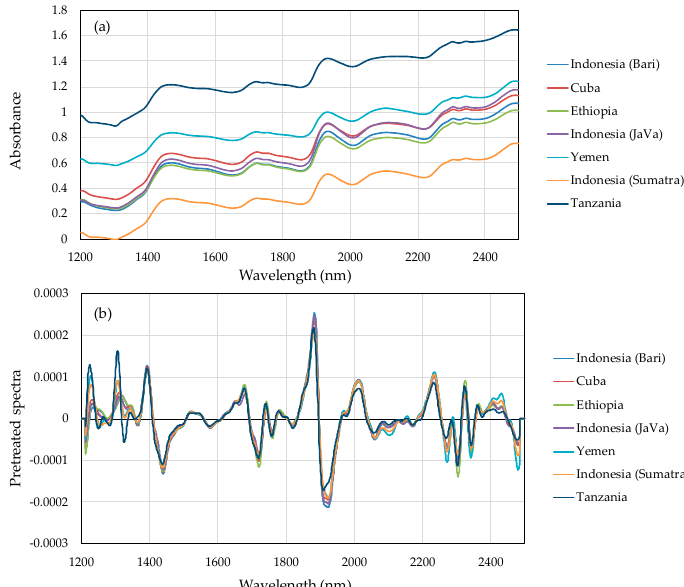
Figure 1. NIR spectra of each green coffee bean from the center cutting face: ( a ) raw spectra and ( b ) pretreated spectra by calculating averaged value per each wavelength.